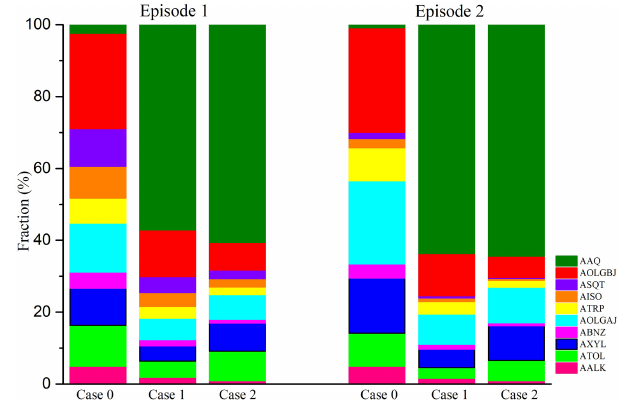
Figure 5. Mean contributions from different sources of SOAs in the three sensitivity case studies during the two analyzed episodes. The compositions represent the SOA formed from long-chain alka- nes (AALK), high-yield aromatic compounds (ATOL), low-yield aromatic compounds (AXYL), benzene (ABNZ), monoterpenes (ATRP), isoprene (AISO), sesquiterpenes (ASQT) and dicarbonyls (AAQ), as well as aged anthropogenic (AOLGAJ) and biogenic SOA (AOLGBJ). Case 0 is the base run; case 1 is run with the incor- poration of the reactive uptake of dicarbonyls (excluding the default in-cloud dicarbonyl oxidations); and case 2 is based on case 1, but taking into consideration the underestimation of